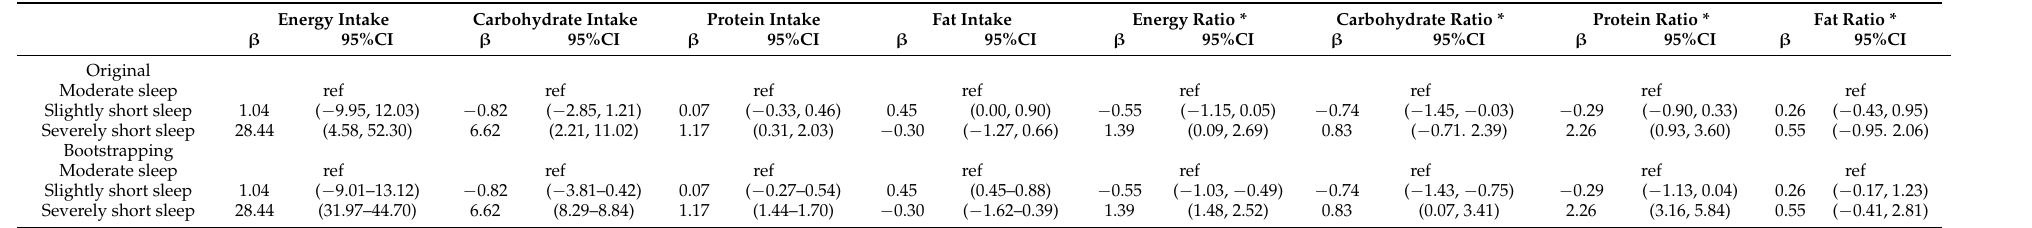
Table 4. Linear regression between sleep duration and breakfast energy and macronutrient intake.